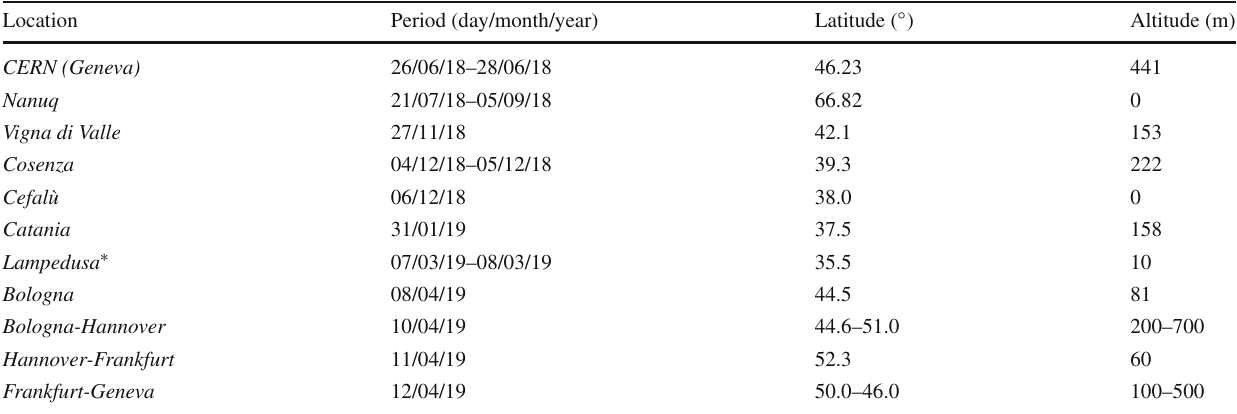
Table 1 List of the locations where POLA-01 took data